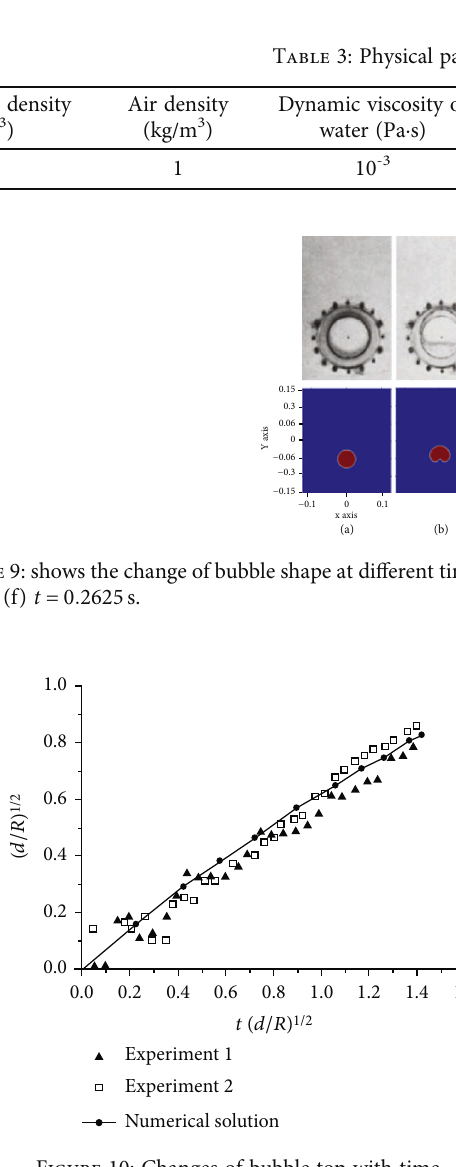
Figure 10: Changes of bubble top with time.